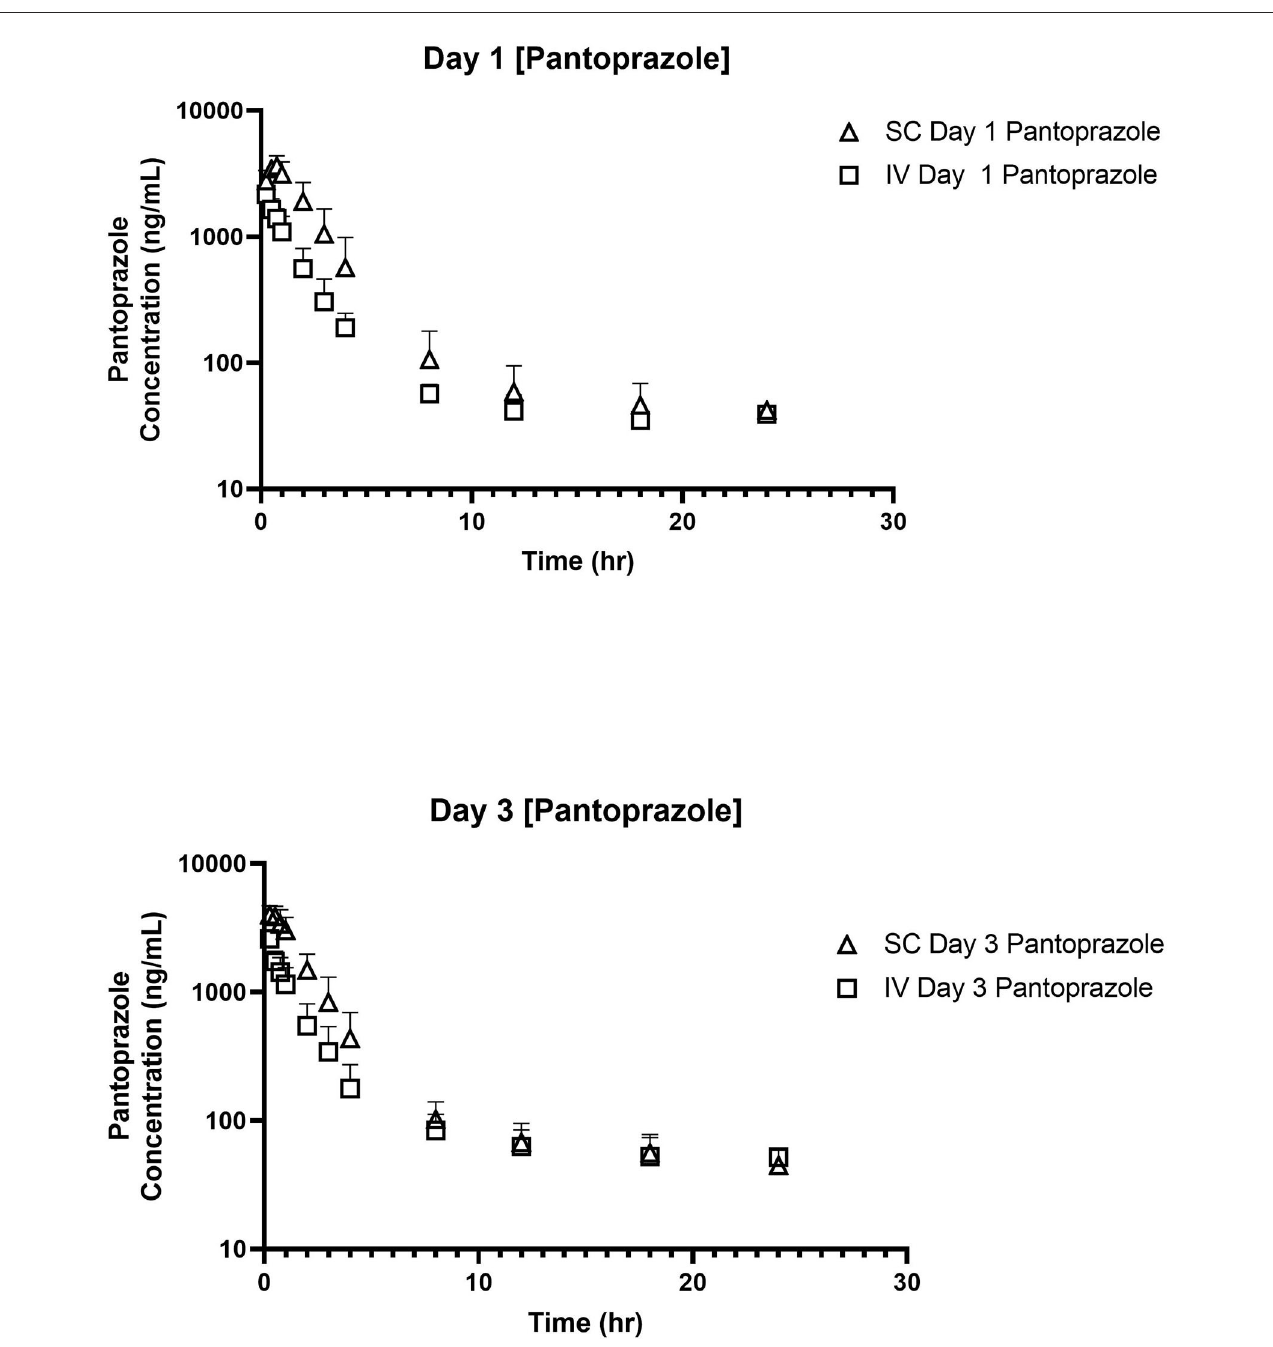
FIGURE1 Time vs. Concentration curves for intravenous (IV; square) and subcutaneous (SC; triangle) administration of pantoprazole on Days 1 (top) and 3 (bottom) .